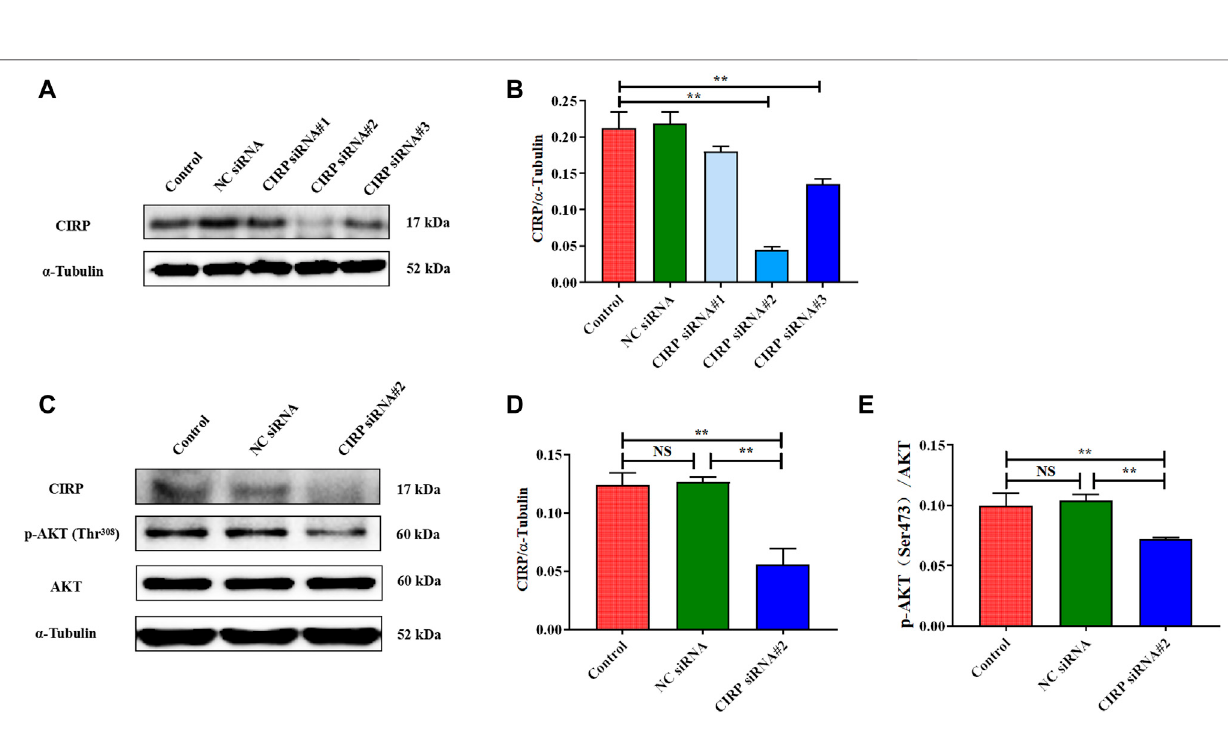
FIGURE7| CIRPknockdownreducesAKTanditsphosphorylationlevels. (A,B) Constructionandef fi ciencydetectionofCIRPsiRNAinterference. (C – E) Effectsof CIRP knockdown on AKT and its phosphorylation. The data are presented as the mean ± SEM (n (cid:1) 8). Statistically signi fi cant differences are indicated; * p < 0.05, ** p < 0.01. CIRP, cold inducible RNA-binding protein; AKT, protein kinase